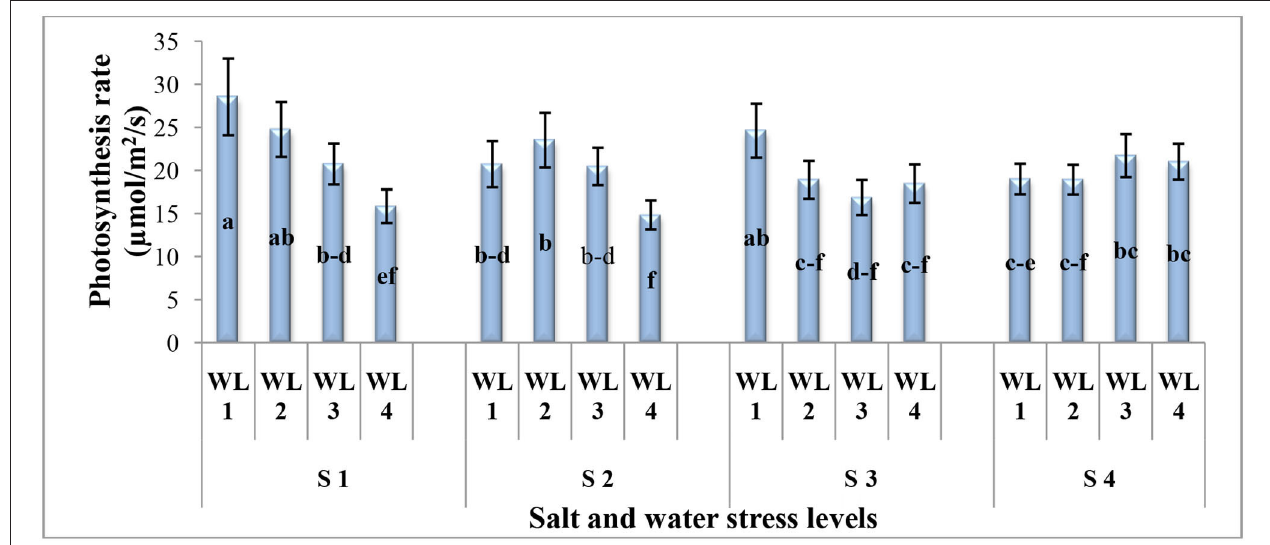
Figure 1 | Interactive effect of salinity and drought stress on the photosynthesis rate ( µ mol m − 2 S − 1 ) of S. imbricata . Value bars with different letters are significantly different from each other at α = 0.05, while error bar represents the standard error of mean ( n = 3). WL stands for water level (WL1 = 100% field capacity, WL2 =